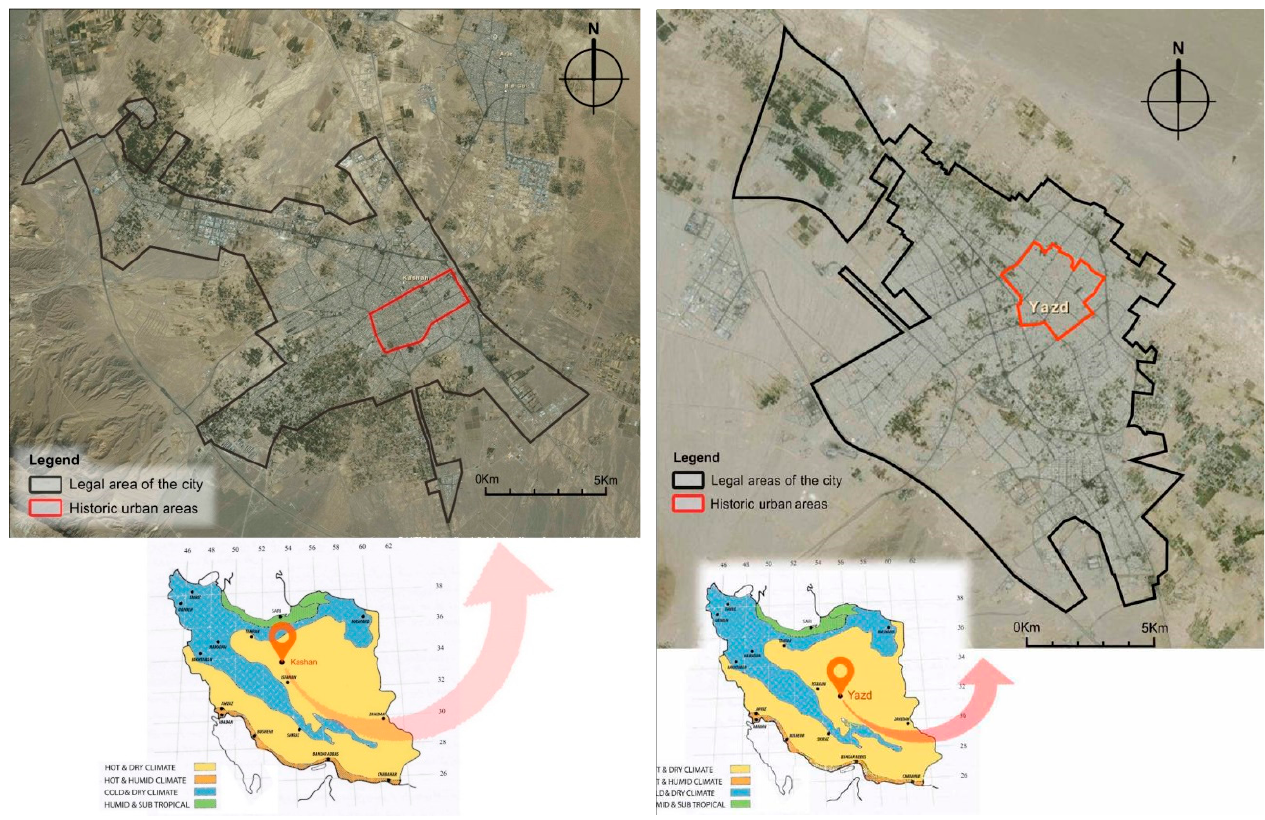
Figure 5. Historic urban areas within the contemporary city of Kashan ( left ) and Yazd ( right ) [31]. Consequently, two urban blocks were nominated in each selected tissue, which should have developed a higher and lower percentage of DABs per urban block, to cap- ture the maximum variation of disused areas. The selection criteria were based on two percentages of DABs in Yazd and Kashan. Accordingly, Darb-i-Isfahan, Mohtasham,